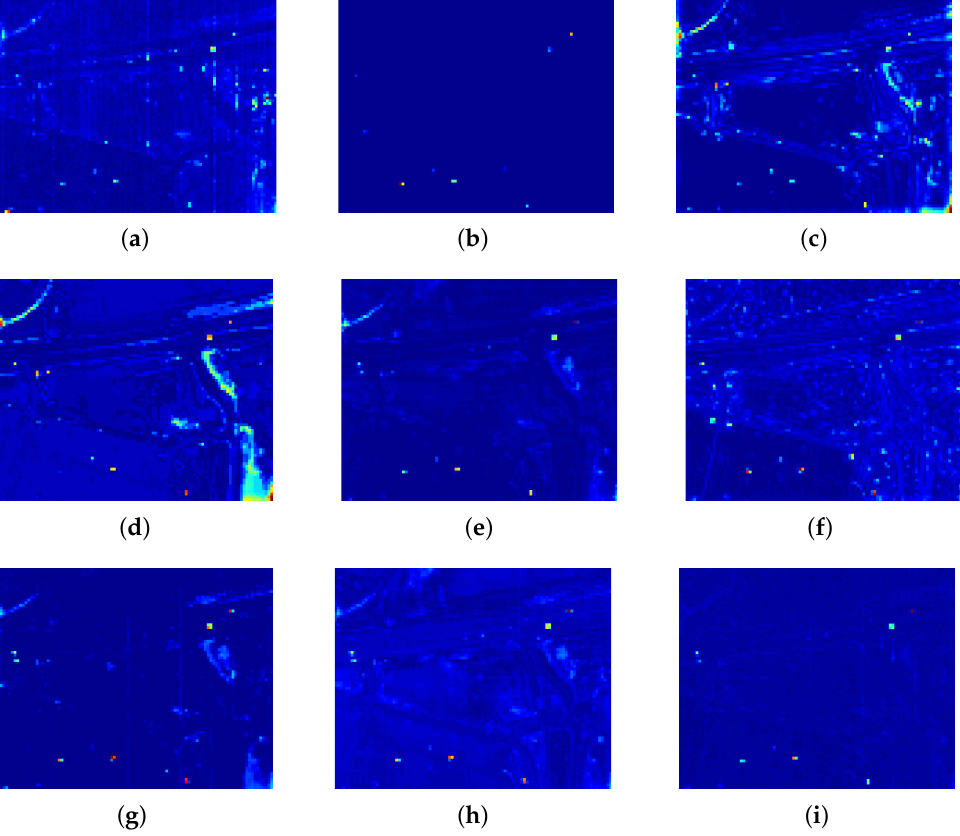
Figure 17. Color detection maps of all compared algorithms for the Urban dataset. ( a ) RX; ( b ) LRX; ( c ) KRX; ( d ) CKRX; ( e ) SSRX; ( f ) CRD; ( g ) LRaSMD; ( h ) LRASR; ( i )